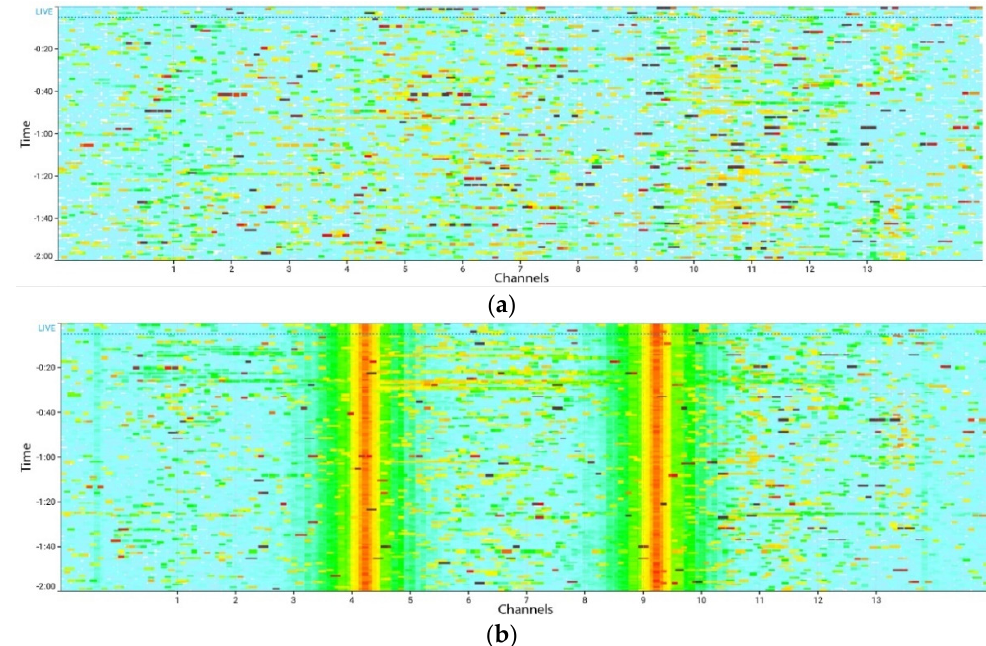
Figure 7. Radiofrequency spectrum activity over time on the PHY layer on the 2.4 GHz band in the ( a ) no interference and ( b ) interference scenarios. The two red vertical lines indicate continuous transmission from the sound transmitter. Darker color indicates greater signal strength.